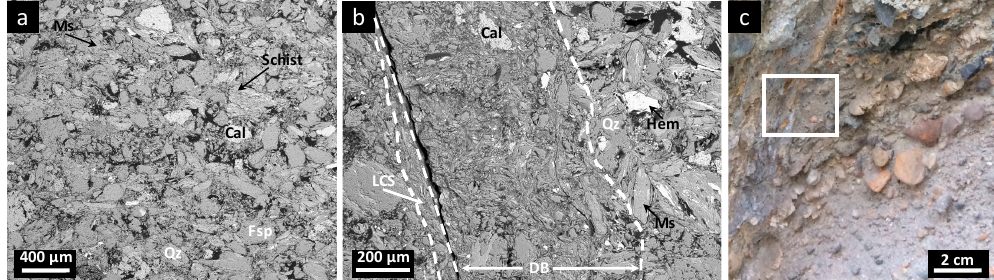
Figure 18. BSE images of samples from the damage zones in the Tablate B locality (S of the Padul Fault). ( a ) Marly lithofacies made of quartz, phyllosilicates, calcite, feldspars and terrigenous grains (e.g., schists). ( b ) Deformation band (DB) in the form of a disaggregation band with phyllosilicate alignment and local clay smearing (LCS) along the band. ( c ) outcrop picture showing the macroscopic fractures of the sample; square indicates the area of the SEM images ( a ) and ( b ). Mineral abbreviations as in Figure 13.